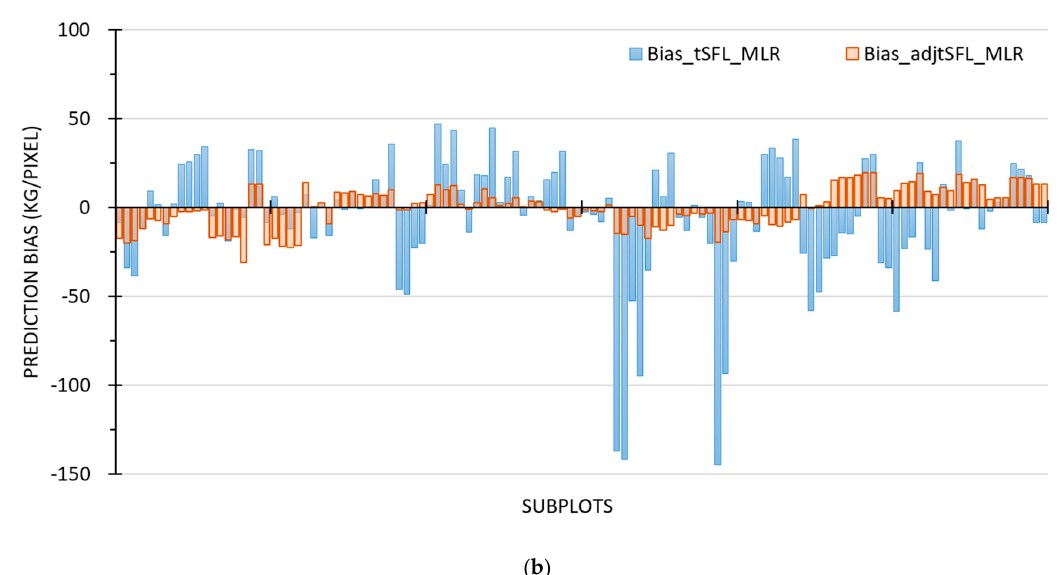
Figure 10. Changes in bias for the surface fuel loading estimation between the original lnfSFL–BioTopo model and its bias-adjustment model ( a ) and the lntSFL–BioTopo model and its bias-adjustment model ( b ).